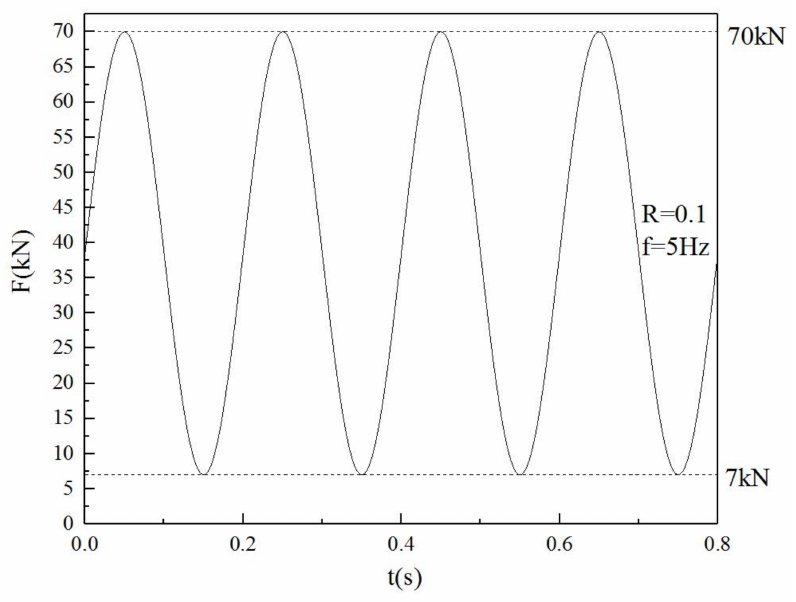
Figure 14. The schematic diagram of the sinusoidal cyclic loading curve for fatigue tests.